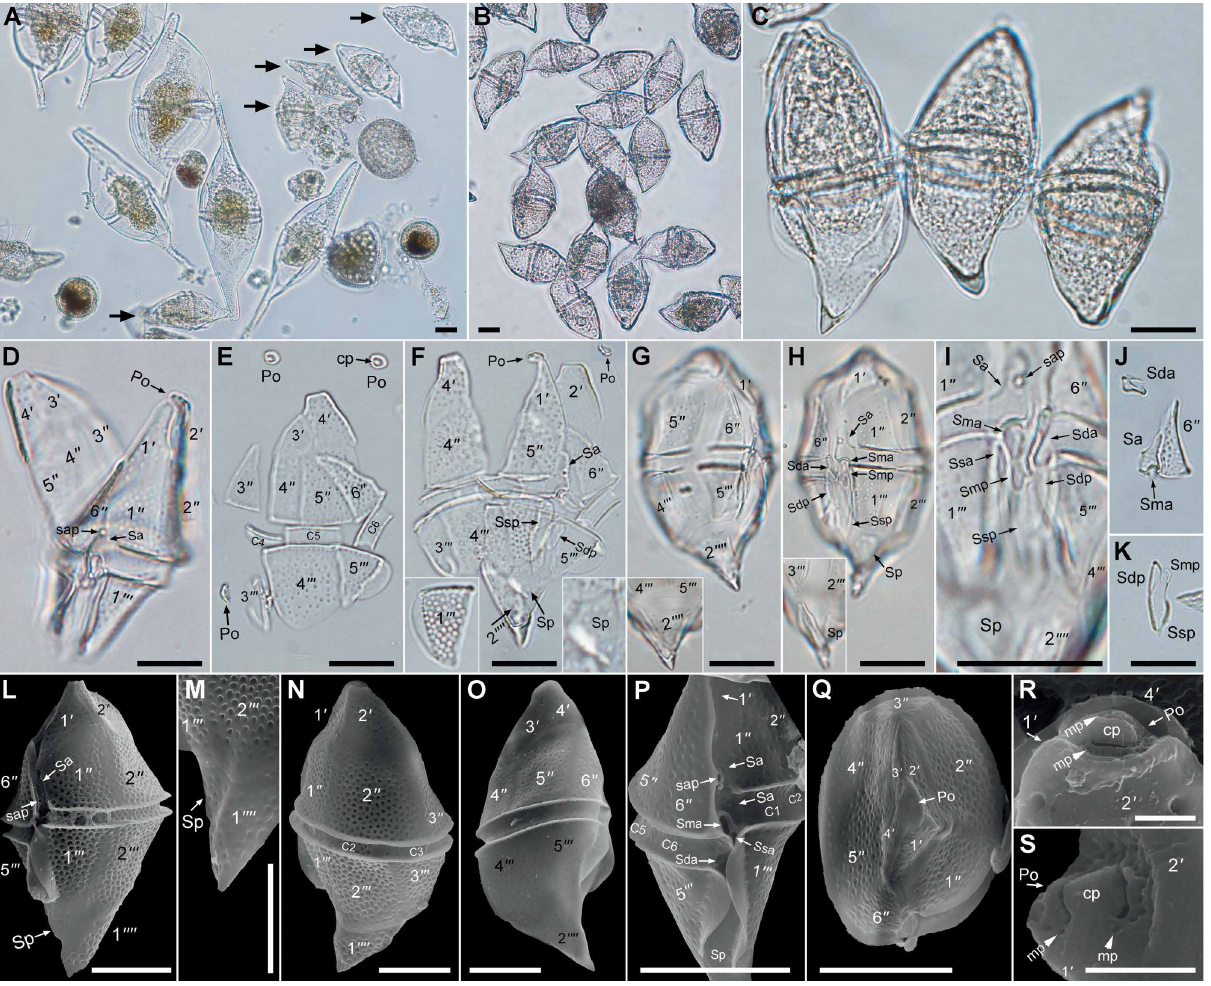
Figure 1: Light (a–j) and scanning electron (l–s) micrographs of Centrodinium punctatum . (a) Plankton sample with Centrodinium spp. The arrows point the cells of C. punctatum. (b–c) Individuals used for molecular analyses. (d) Partially dissociated theca in ventral view. (e–f) Epitheca. The insets show the first postcingular plate and the posterior sulcal plate. (g) Right-ventral face. The inset shows the right antapex. (h) Left-ventral view. The inset shows the dorsal antapex. (i) Ventral view of the sulcal area. (j-k) Dissociated sulcal plates. (l) Left-ventral view. (m) Left antapex. (n) Left face. (o) Right face. (p) Ventral view. (q) Apical view. (r–s) Apex. 1 surrounding the apical pore plate; Po = apical pore plate; S.a. = anterior sulcal plate; s.a.p. = pore of the anterior sulcal plate; S.d.a. = right (dexter) anterior lateral sulcal; S.d.p. = right posterior lateral sulcal; S.m.a. = anterior median sulcal; S.m.p. = posterior median sulcal; S.p. =